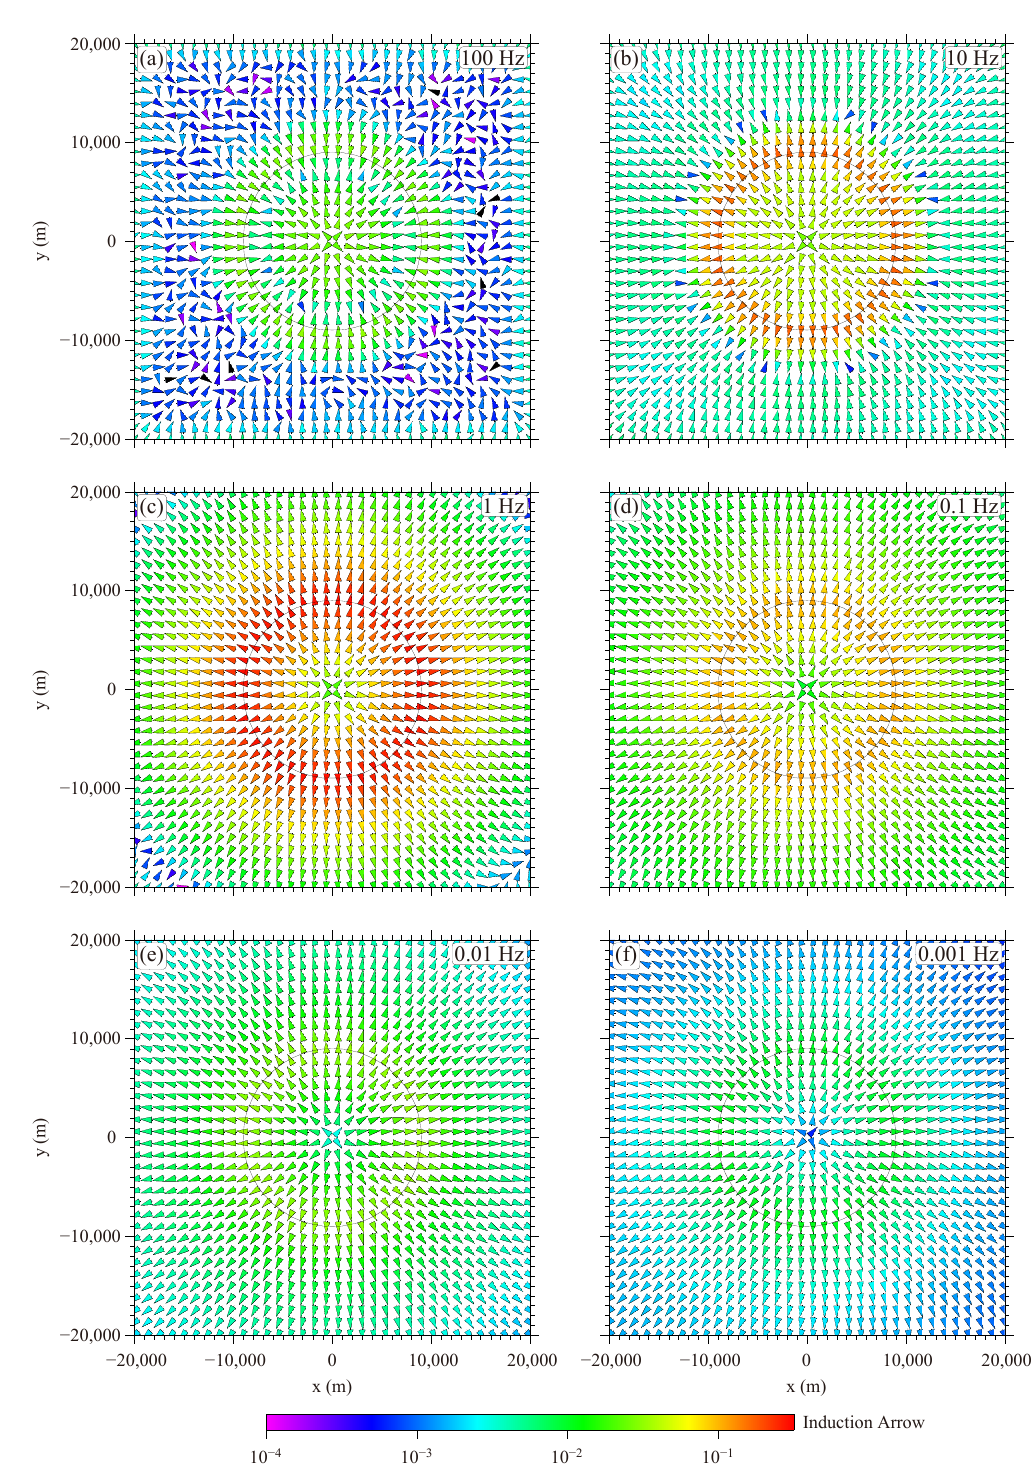
Figure 16. The vector maps of the induction arrows of Model 13 for the HDR and partial melting system, as shown in Figure 13. ( a – f ) are for the frequencies of 100, 10, 1, 0.1, 0.01, and 0.001 Hz, respectively. The black circles indicate the projection of the clay cap on the x - y plane.